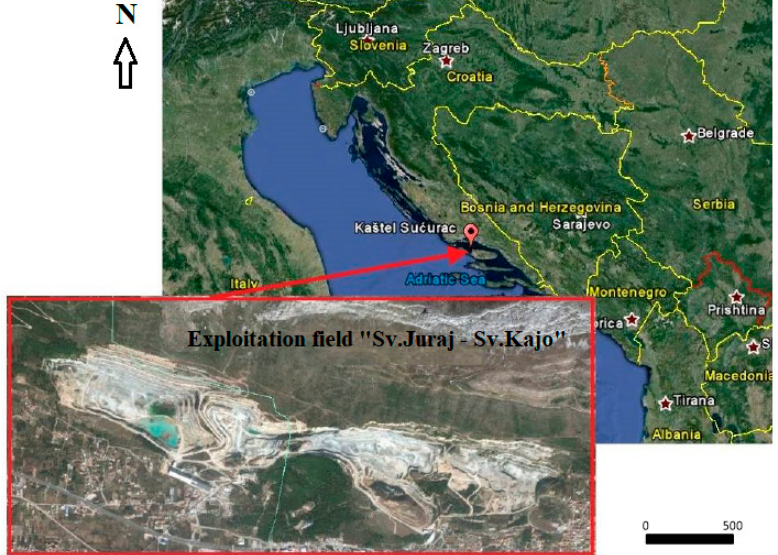
Figure 1. Geographic location of the exploited field “St. Juraj–St. Kajo” (after [19]). The flysch is a dominant lithology, which is a descriptive term used to denote In the raw material deposits the following lithological units are proven (Figure 2): (1) marl/sandstone changes with conglomerate alterations; (2) limy (calcitic) marl; (3) calc- siltite (clayey limestone); (4) calcarenite; (5) nummulitic marl; and (6) debrites (Figure 3a– f) [20]. Here, clayey marl (7) is also added, as lithofacies of the marginal parts of (1) and